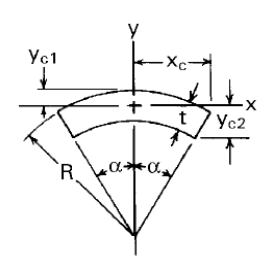
Figure 23: Sector of hollow circle